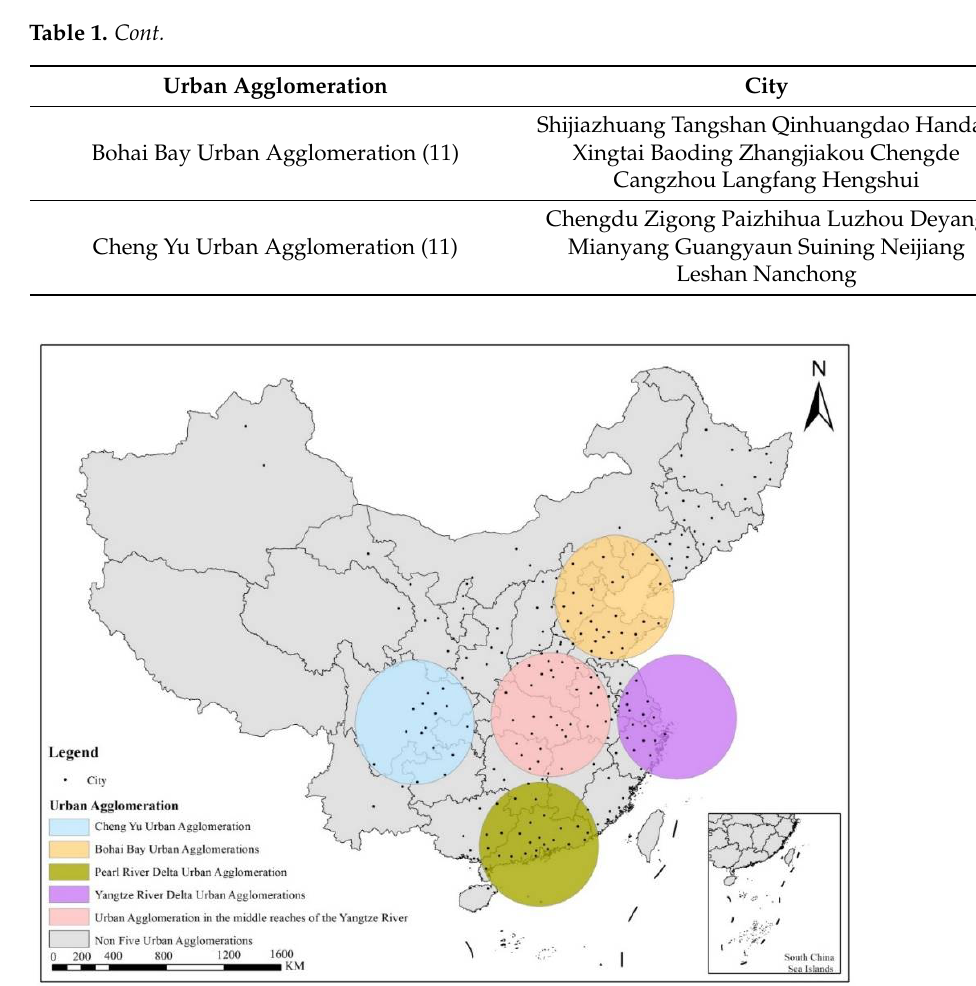
Figure 1. Location of five urban agglomerations in China.